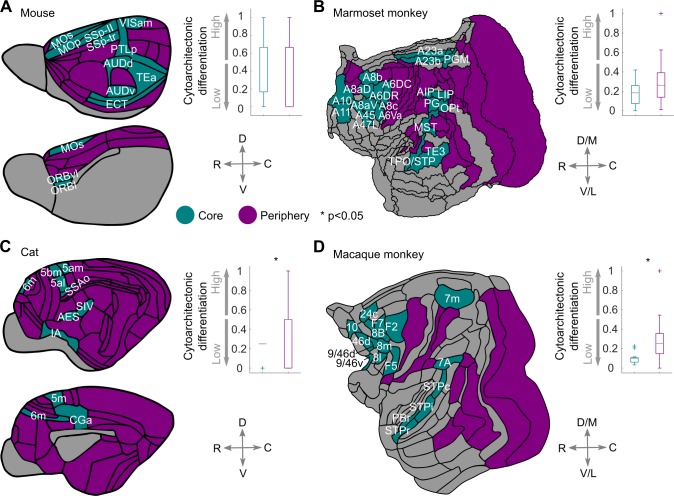
Core–periphery network topology and cytoarchitecture.The structural network core of the (A) mouse, (B) marmoset monkey, (C) cat, and (D) macaque monkey. Areas of the structural network core of the mouse and marmoset monkey do not exhibit statistically significant cytoarchitectonic differences with the areas of the periphery. In contrast, in the cat and macaque monkey, areas of the core differ significantly from areas of the periphery, with core areas exhibiting lower cortical types and neuronal density, compared to periphery areas. Boxplot edges, gray lines, and whiskers and crosses depict the 25th and 75th percentiles, median, and extreme nonoutlier and outlier values, respectively. Differences of the distributions of the core and periphery values were assessed with the Kolmogorov-Smirnov or the statistical energy test, and statistical significance was assessed with permutation tests. Note that areas colored in gray were not part of the core–periphery analyses because of a lack of data. For visualization purposes, the cytoarchitectonic status of cortical areas (cortical type or neuronal density) was linearly rescaled to the 0–1 interval. For the mouse and macaque monkey core, see also [20, 21]. See S1 Table for full names of the cortical areas. C, caudal; D, dorsal; D/M, dorsal/medial; R, rostral; V, ventral; V/L, ventral/lateral.